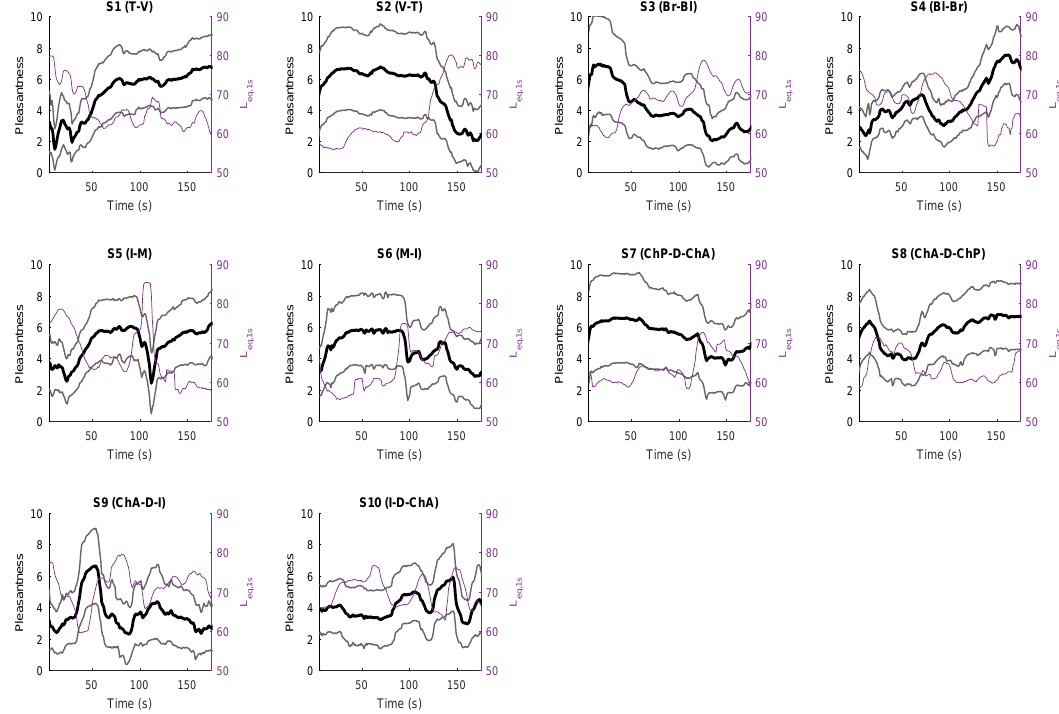
Figure 5. Continuous perceived pleasantness, mean values over participants P mean (thick black line), standard deviations (light black lines), and sound level ( L eq,1s , purple) over time for the 16 sequences. There is a statistically significant difference in the ∆ GP-P mean values between the sequences, as determined by the one-way ANOVA ( F (9,286) = 2.97, p < 0.01), which implies that the global assessment is not only the average of the continuous ones. Table 4 shows P mean and GP , along with their differences ∆ GP-P mean , for each sequence. A more detailed analysis of the pairs of sound sequences (two of the same trips, but run in opposite directions) leads to contrasted conclusions. For S3 & S4 and S5 & S6, which are only composed of two different sound environments, the expected tendencies are observed: sequences that evolve towards improved sound environments show higher ∆ GP-P mean values than sequences that evolve towards deteriorated sound environments. Nevertheless, these tendencies are not statistically significant ( p > 0.05). This tendency is also contradicted by the sequences S1 & S2, S7 & S8, and S9 & S10, which show ∆ GP-P mean values that are not in accordance with any recency effect. Table 4. Pleasantness averaged both over participants and over time ( P mean ), the global sound pleasantness ( GP ) averaged over participants, and the difference between both ( ∆ GP-P mean ), for each of the 16